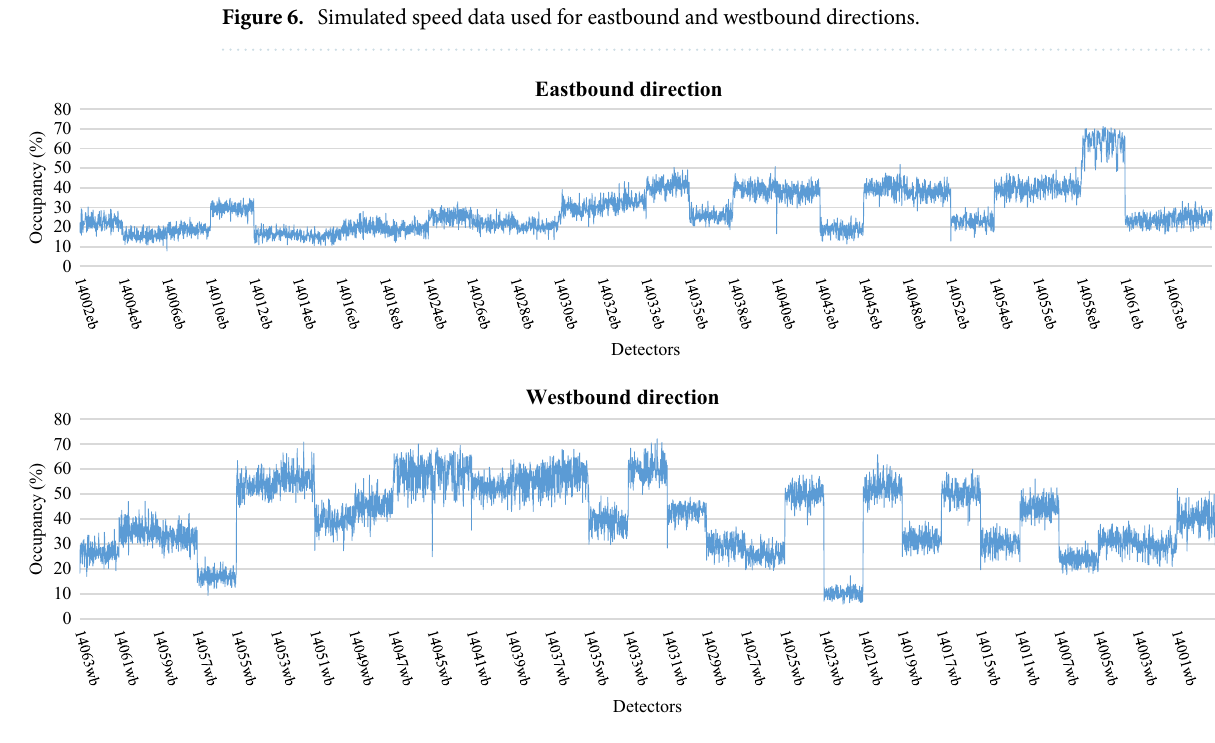
Figure 7. Simulated Occupancy data used for eastbound and westbound